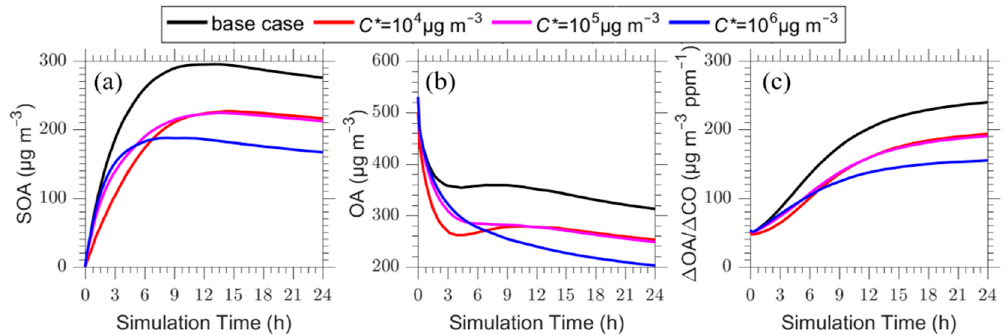
Figure 7. Time series of: ( a ) SOA; ( b ) total OA; and ( c ) Δ OA/ Δ CO for the plume centerline after zeroing the emissions in the C * = 10 4 μ g m − 3 ( red line ), 10 5 μ g m − 3 ( magenta line ) and 10 6 μ g m − 3 ( blue line ) volatility bins. The base case ( black line ) is also shown.